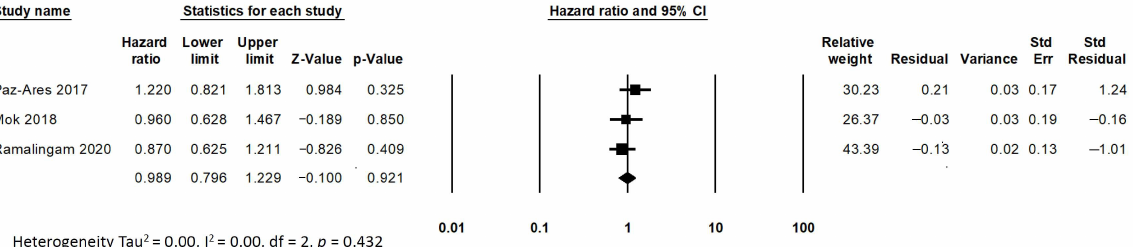
Figure 4. Analysis for the overall survival of the EGFR TKIs in older adult patients (The effect size for each study is represented by a square, with the location of the square representing both the direction and magnitude of the effect. The summary effect is represented by a diamond. The location of the diamond represents the effect size while its width reflects the precision of the estimate.) [13,15,17].